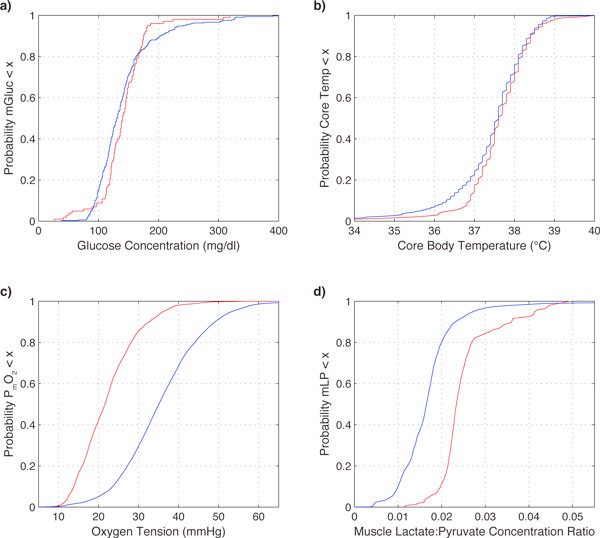
Empirical cumulative distribution functions. Empirical cumulative distribution functions for four physiological variables grouped according to whether pressors were being administered (red) or not (blue). (a) Finger stick glucose readings do not differ significantly. (b) Core body temperature undergoes a statistically significant difference but is unlikely to be clinically significant. (c) Muscle oxygen tension and (d) muscle lactate:pyruvate ratio both show statistically significant changes upon administration of pressors and the changes appear to be clinically different as well.